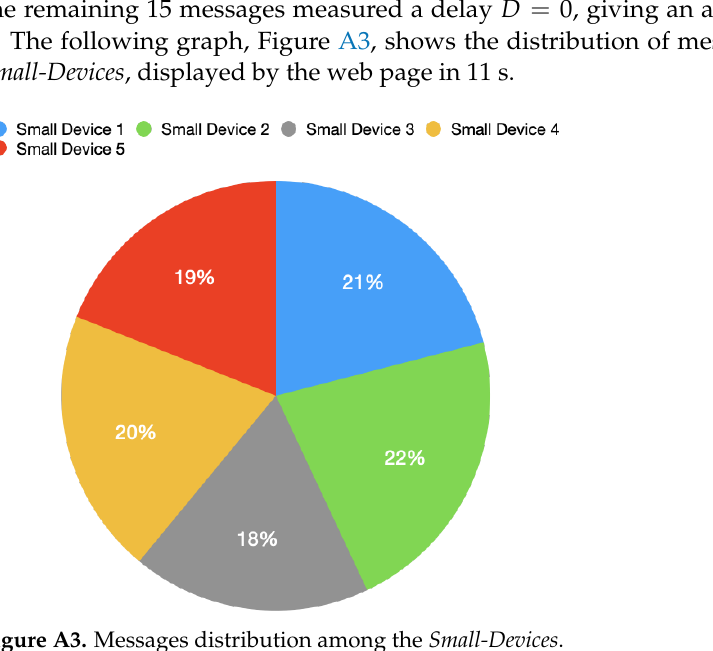
Figure A3. Messages distribution among the Small-Devices . Even with five Small-Devices simultaneously monitored, the Belt-Device is able to communicate their connections to the Edge-Device, continuously and almost uniformly, occupying still a small part of the channel